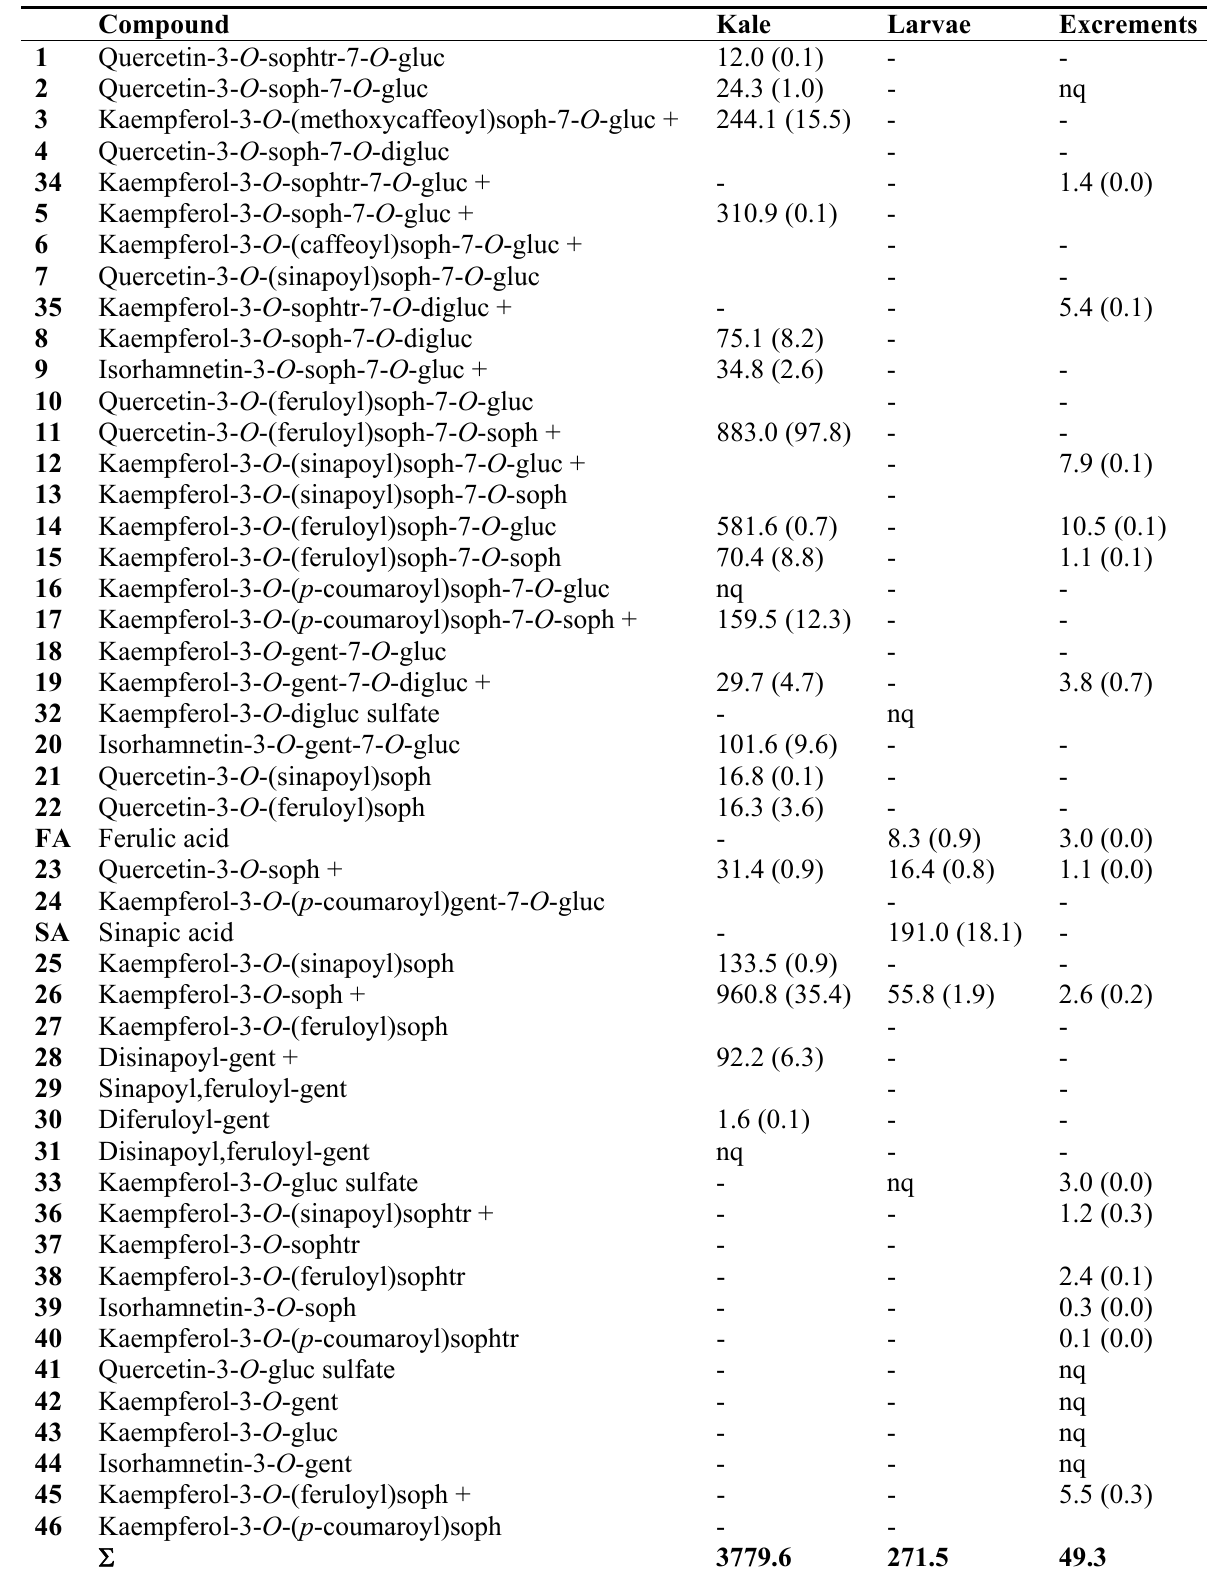
Table 1. Quantification of phenolic compounds in methanolic extracts of B. oleracea var. acephala and P. brassicae materials (mg/kg, dry basis) a . Compound Kale